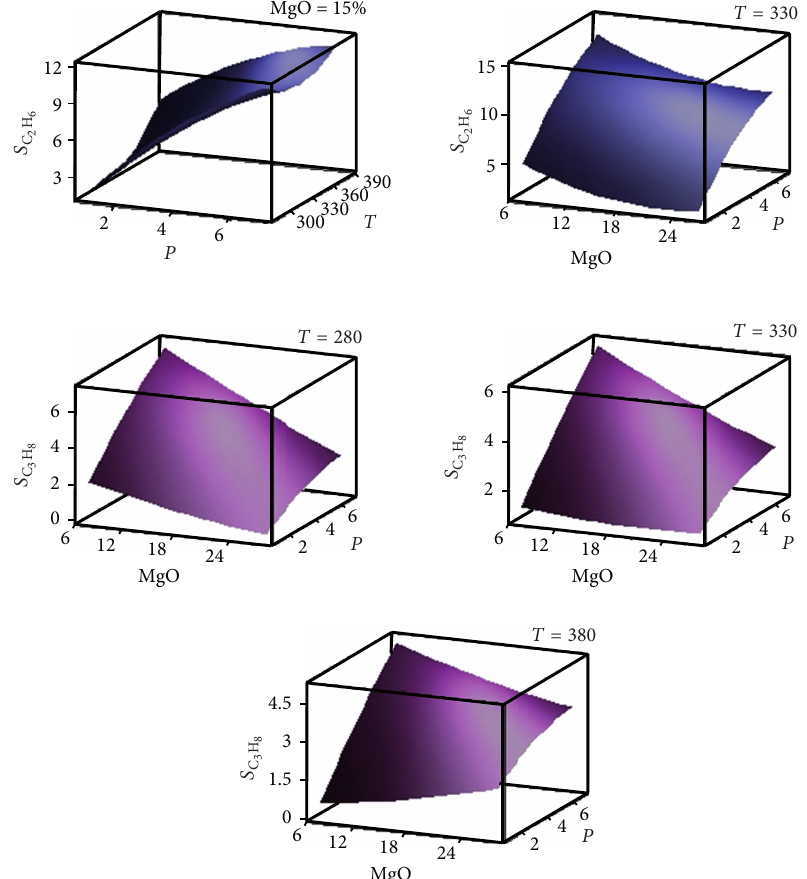
F 3: Effect of temperature, pressure, and structural promoter on the propane and ethane selectivity. MgO decreses the ethane and propane selectivity and pressure increases the